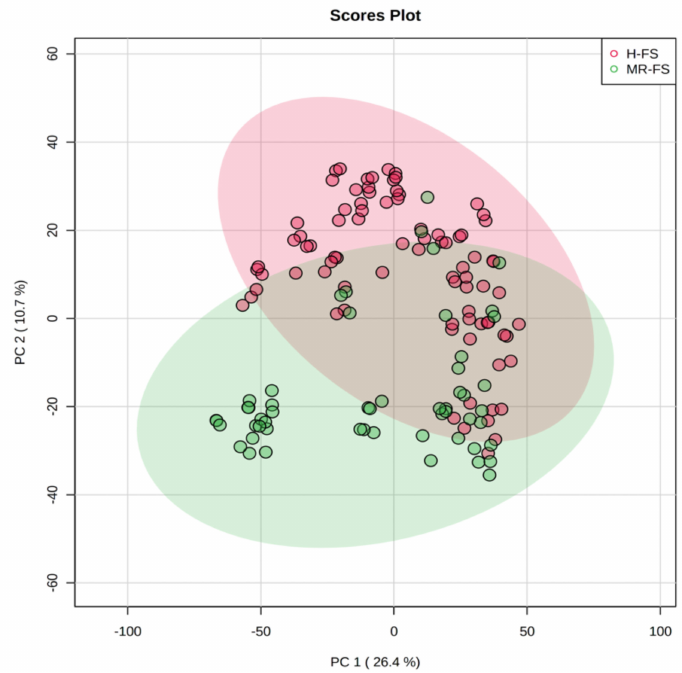
Figure 1. Unsupervised principal component analysis considering the milk samples from different feeding regimens (i.e., H-FS: hay-based feeding system; MR-FS: fresh forage/hay-based feeding system). The different colored ellipses represent milk samples grouped according to the declared feeding